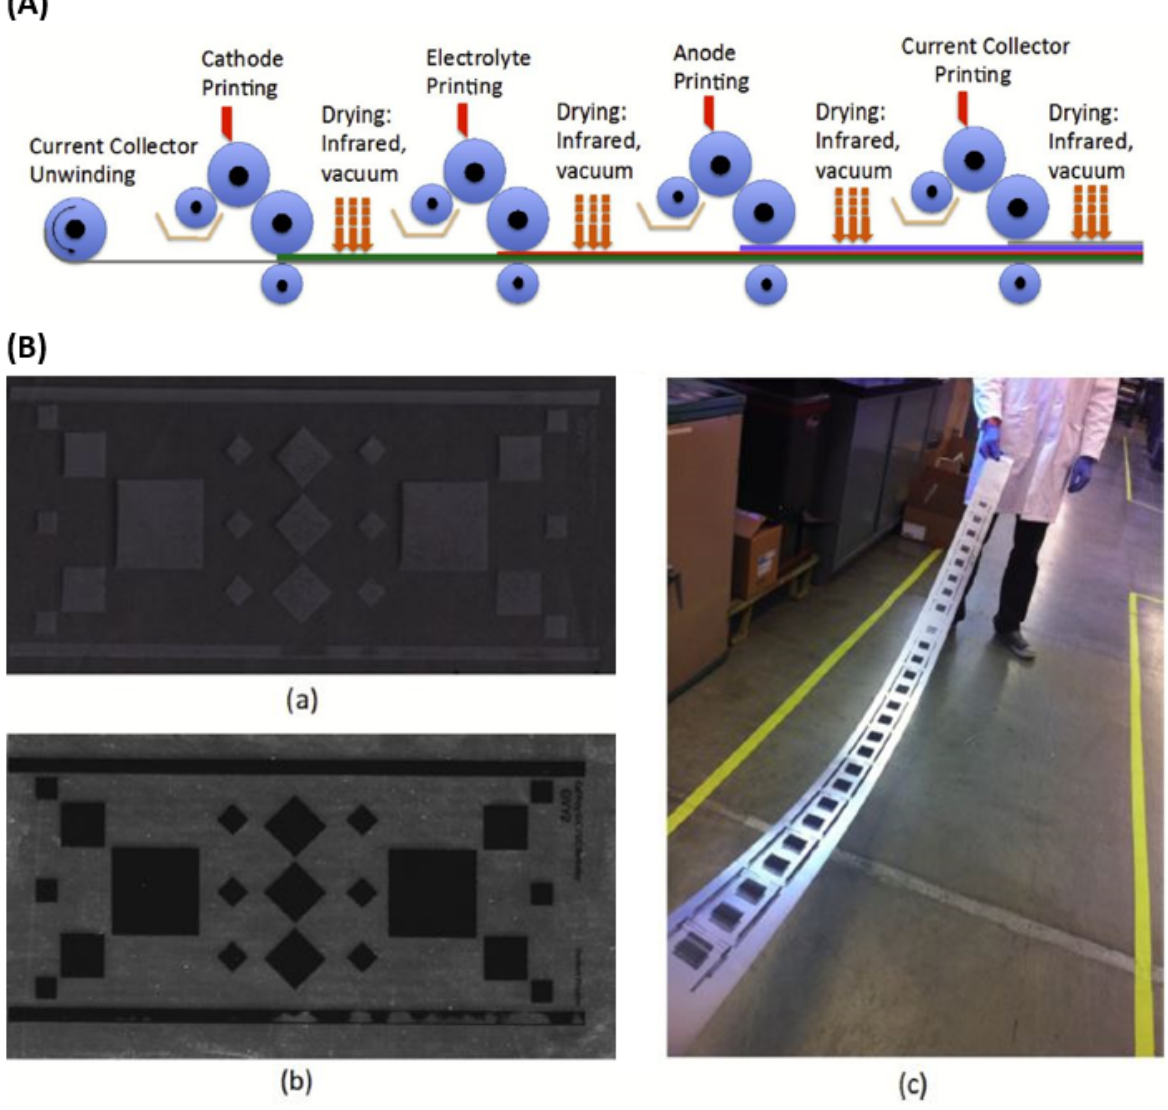
Figure 7. ( A ) The proposed multi-station flexographic printing process for large-scale battery pro- duction. ( B ) Significant improvement in printing quality on stainless steel foils by using cathode slurry inks with different polymeric binding solutions: ( a ). Printed films from MnO 2 cathode ink formulations with CMC/SBR binder; ( b ). Improved printed films from cathode ink formulations with PSBR binder; ( c ). Five continuous printed PSBR cathode films on a piece of stainless-steel foil. Reproduced with permission. Ref. [26] Copyright 2014. Elsevier.